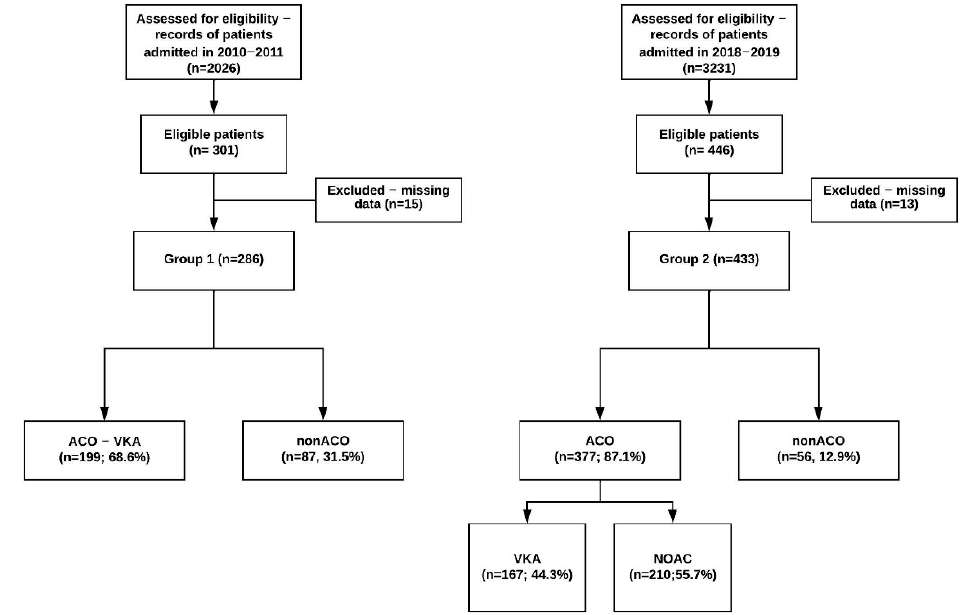
Figure 1. Flowchart of the patients included in the study. Pts = patients; ACO = with anticoagulation upon discharge; nonACO = without anticoagulation upon discharge, VKA = vitamin K antagonists. Table 2. Demographic and clinical data of patients included in the study between 2010–2011 (group 1) and 2018–2019 (group